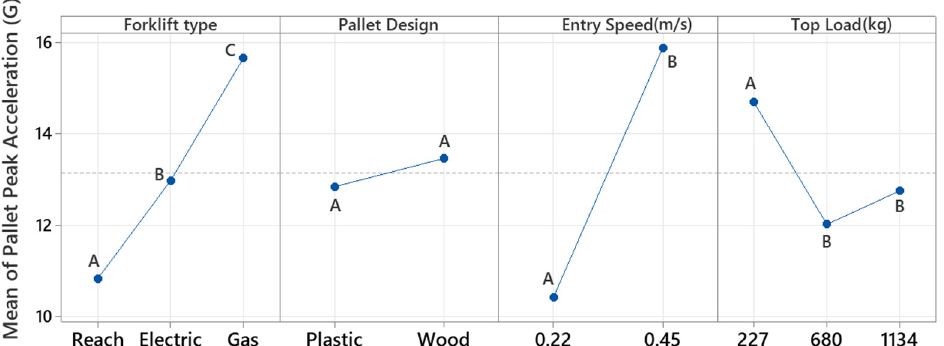
Figure 6. Main effects plot for pallet peak acceleration. Tukey pairwise comparison indicates means that do not share a letter are significantly different at α = 0.05.